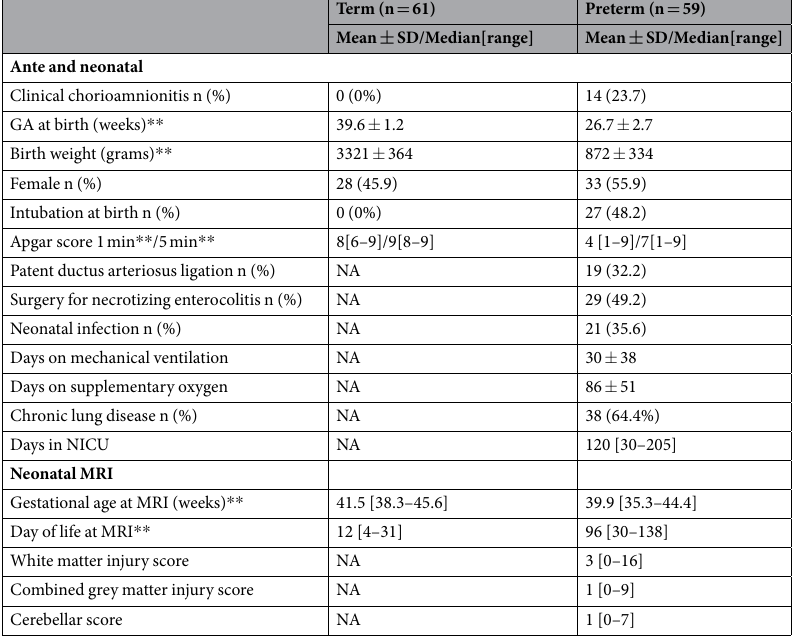
Table 1. Clinical characteristics of the cohort (N = 120). Legend: ** p < 0.01.